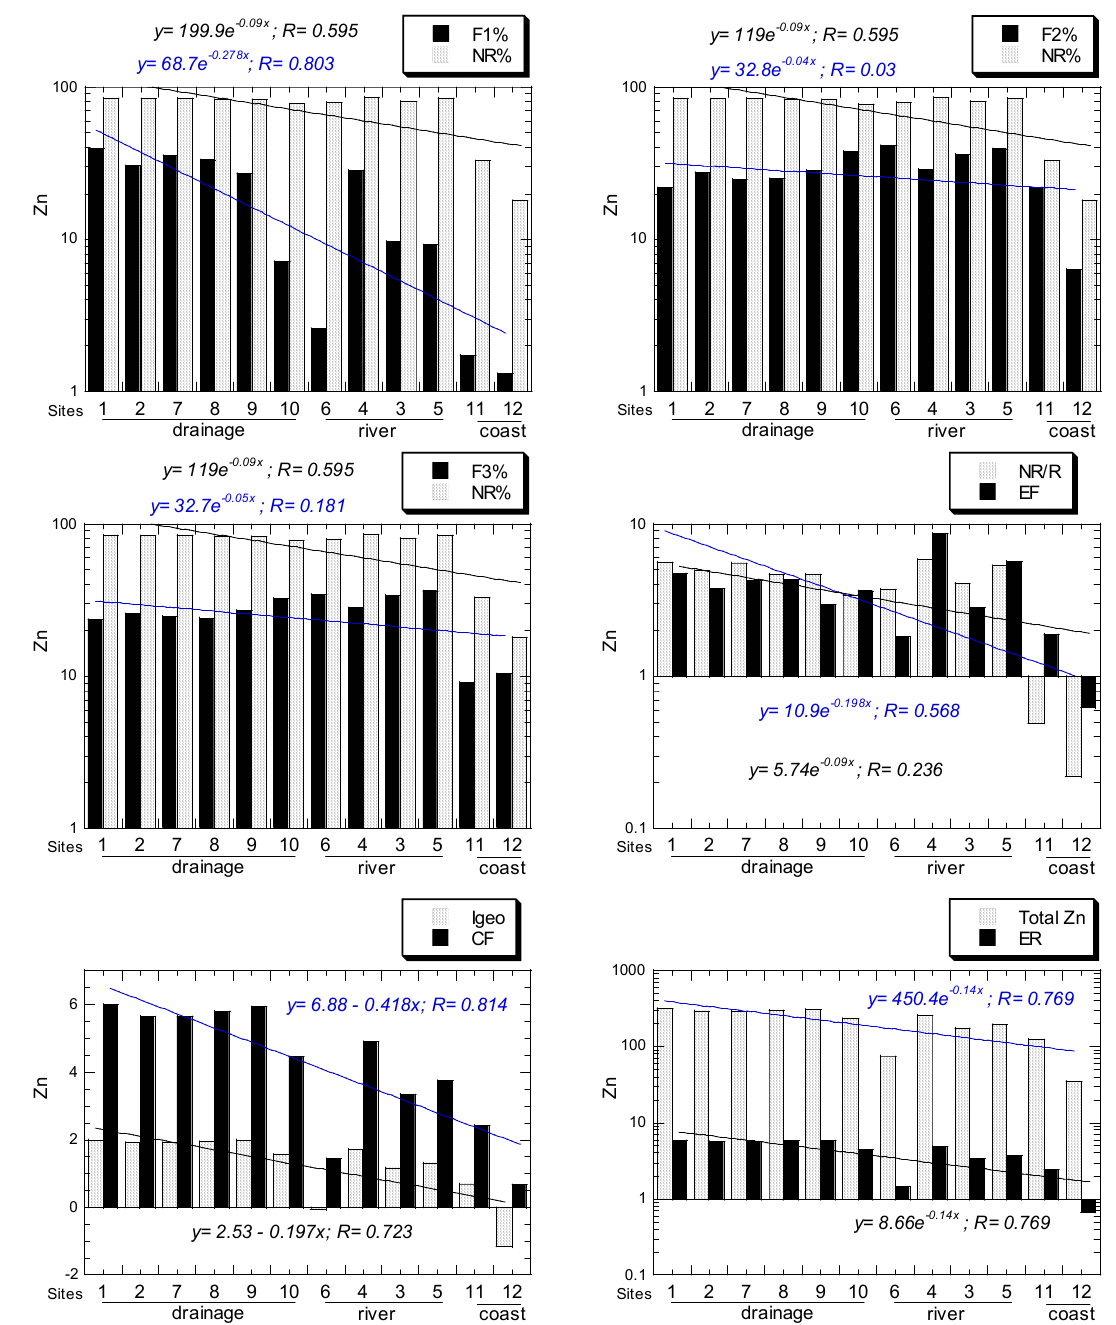
Figure 6. Zn percentages of "easily, freely leachable or exchangeable" (F1; %), "acid-reducible" (F2; %), "oxidisable-organic" (F3; %), and non-resistant (%) fractions, ratios of non-resistant to resistant fractions (NR/R; unitless), enrichment factor (EF; unitless), geoaccumulation index (I geo ; unitless), contamination factor (CF; unitless), total Zn concentrations (Total Zn; mg/kg dry weight), and ecological risk (ER; unitless) of Zn. Note: hyphen (-) means minus.